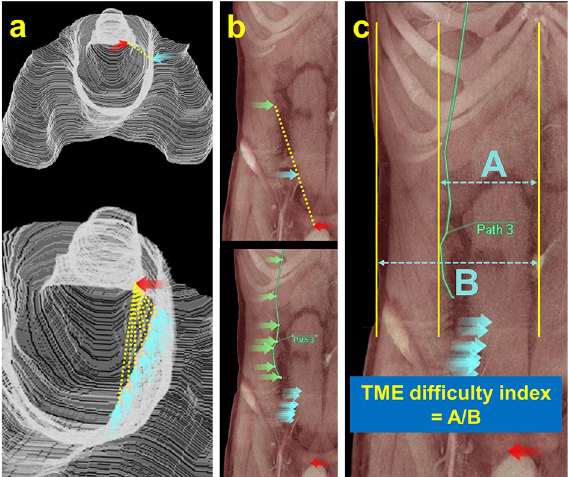
Figure 2. Definition and calculation of the total mesorectal excision (TME) difficulty index. ( a ) The right side of the anal canal at the level of the anorectal junction was marked on the three-dimensional TME dissection plane (red arrow). Subsequently, the points from where the marked point on the right side of the anal canal could be accessed without any hindrance were marked (blue arrows). ( b ) By extrapolation of the line connecting the red arrow and blue arrows to the abdominal surface (green arrow), the right boundary on the abdominal surface from where the marked point on the right side of the anal canal can be accessed without any hindrance was determined (green line). ( c ) The maximum distance from the navel to the right boundary (A) and the distance from the navel to the right edge of the abdominal wall (B) were measured. The TME difficulty index was defined as the ratio of these two distances (A/B) on the assumption that the smaller the index, the greater the difficulty of accessing the deep pelvis and, consequently, the greater the difficulty of